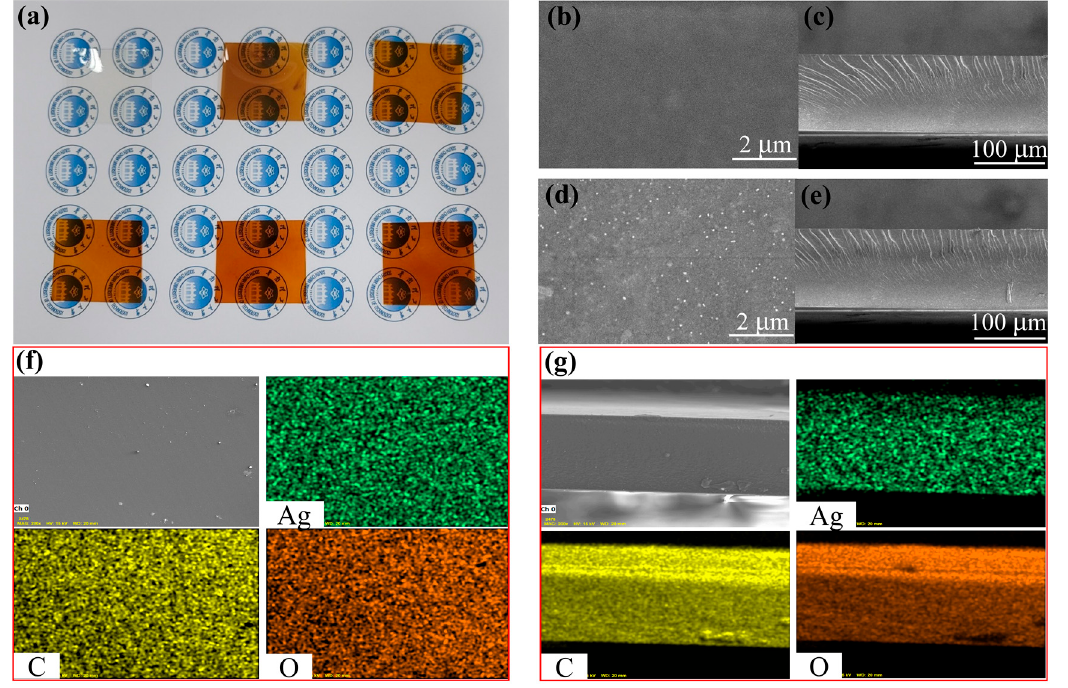
Figure 6. Optical photograph of DAC@Ag0-DAC@Ag5 films ( a ), SEM images of the plane and cross section of DAC@Ag0 film ( b , c ) and DAC@Ag1 film ( d , e ), EDS element mapping of composite film planes ( f ) and cross sections ( g ).